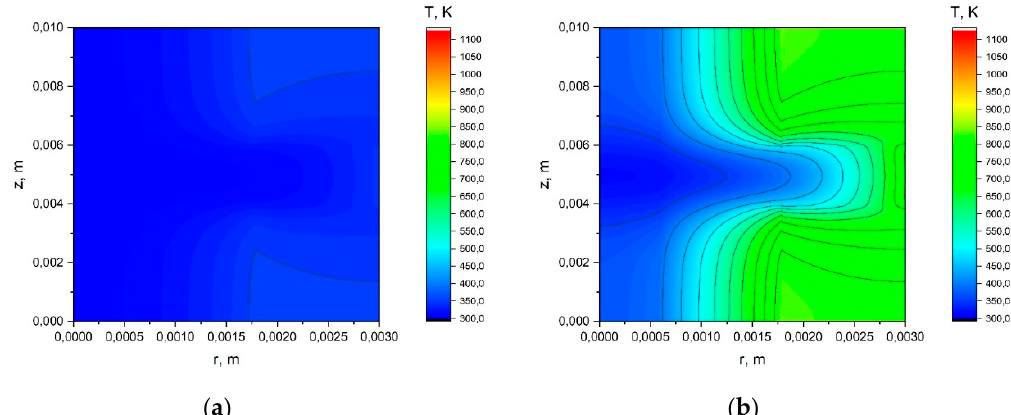
Figure A26. Temperature distribution in the stem of a herbaceous plant: R = 0.003 m, t = 3 s, q = 3 kW/m 2 ( a ); R = 0.003 m, t = 3 s, q = 30 kW/m 2 ( b ).